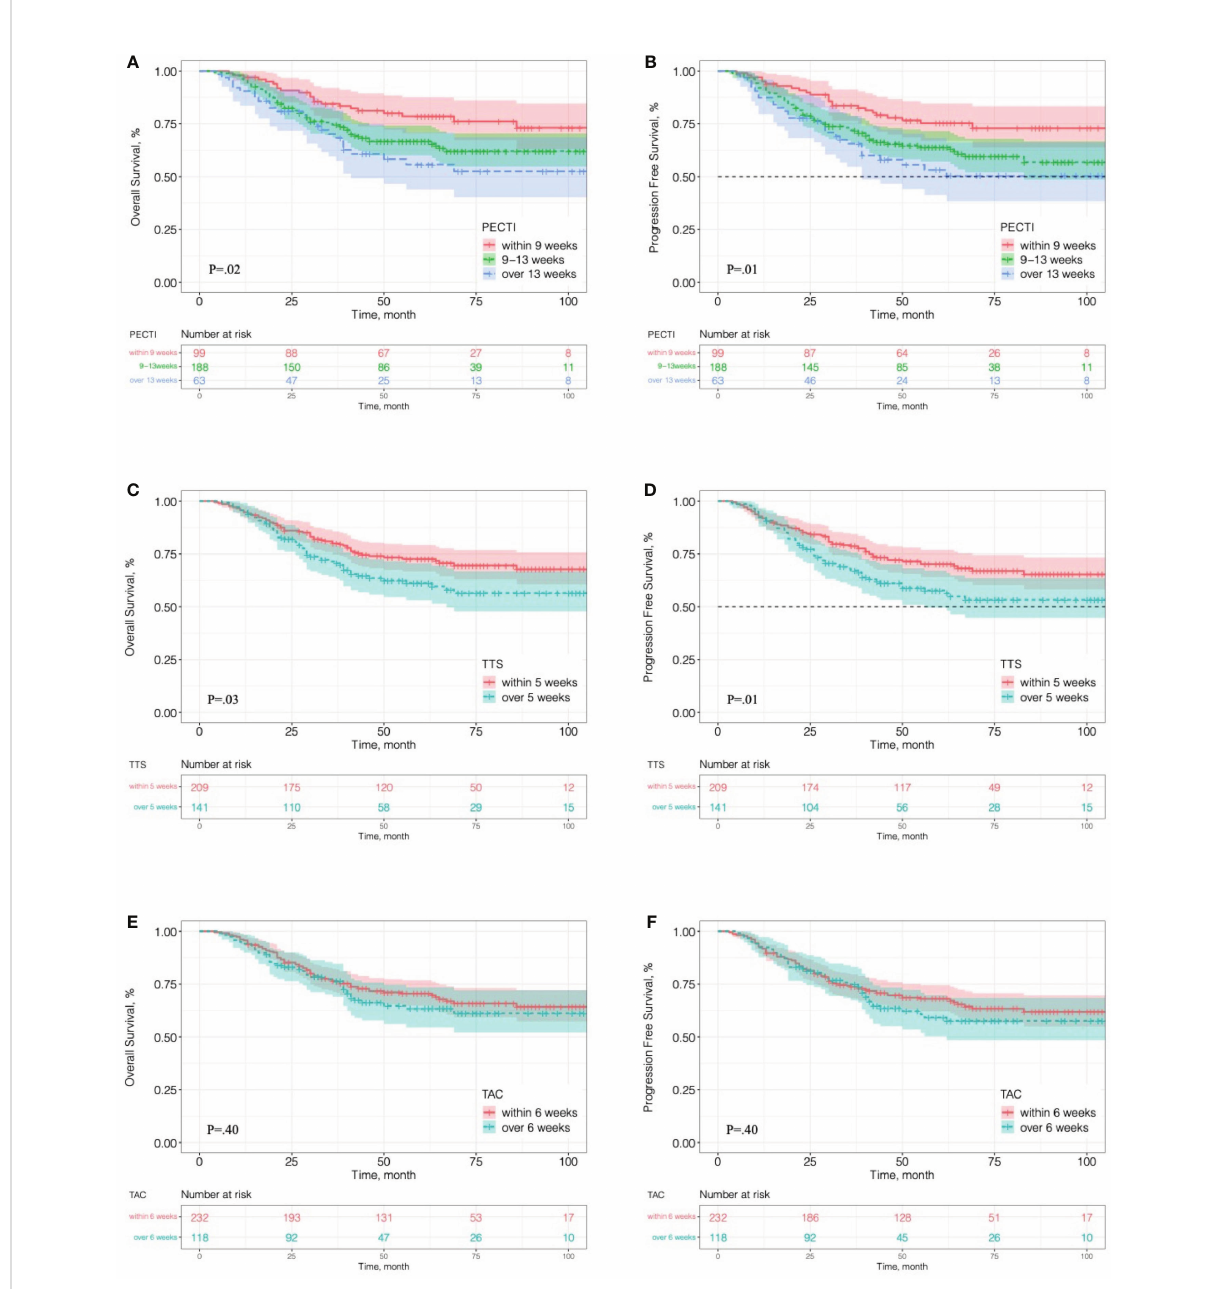
FIGURE 3 Kaplan – Meier analyses of overall survival and progression-free survival in different time interval groups. (A) OS in the trichotomous PECTI study group; (B) PFS in the trichotomous PECTI study group; (C) OS in the dichotomous TTS study group; (D) PFS in the dichotomous TTS study group; (E) OS in the dichotomous TAC study group; (F) PFS in the dichotomous TAC study group. PECTI, perioperative chemotherapy time interval; TTS, time to surgery; TAC, time to adjuvant